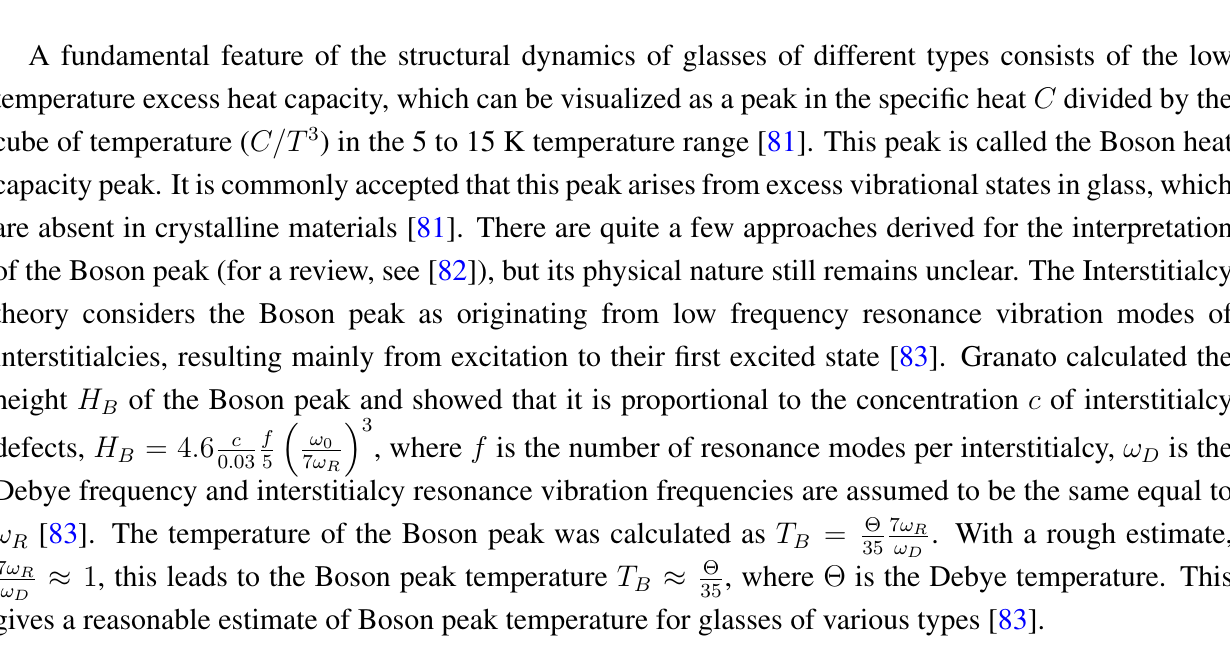
Figure 10. Interstitialcy defect concentration in bulk glassy P d using Equation (1) together with the height of the Boson heat capacity peak as a function of the pre-annealing temperature T seen that the dependencies of the defect concentration c and Boson peak height on T be superposed, indicating the direct proportionality between them and confirming, thus, the interstitialcy interpretation of the Boson peak